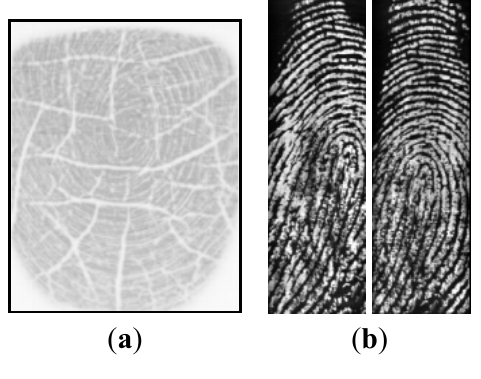
Figure 2. Example of fingerprint ( a ) with lots of cuts; ( b ) captured by a narrow-swiped